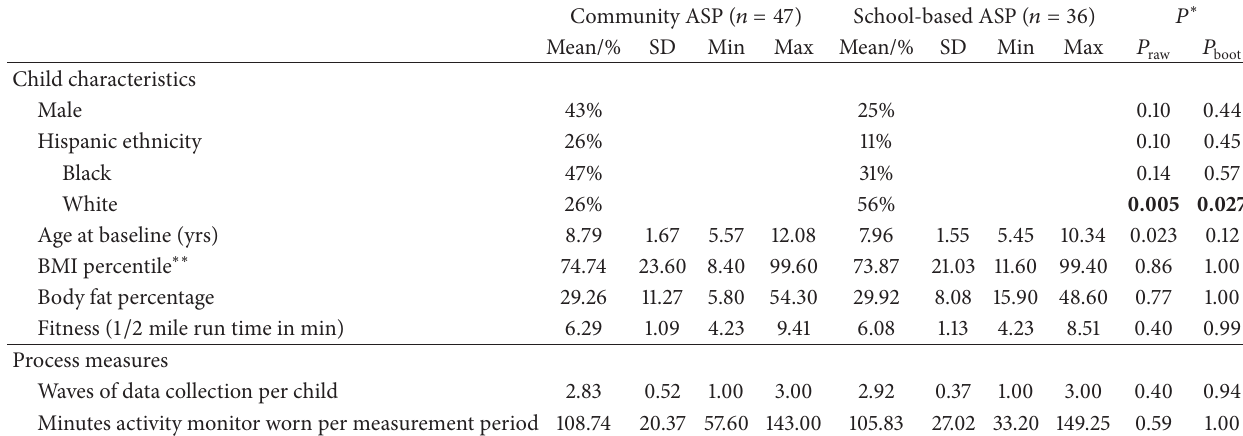
Table 2: Between-group comparison of baseline and process measures.